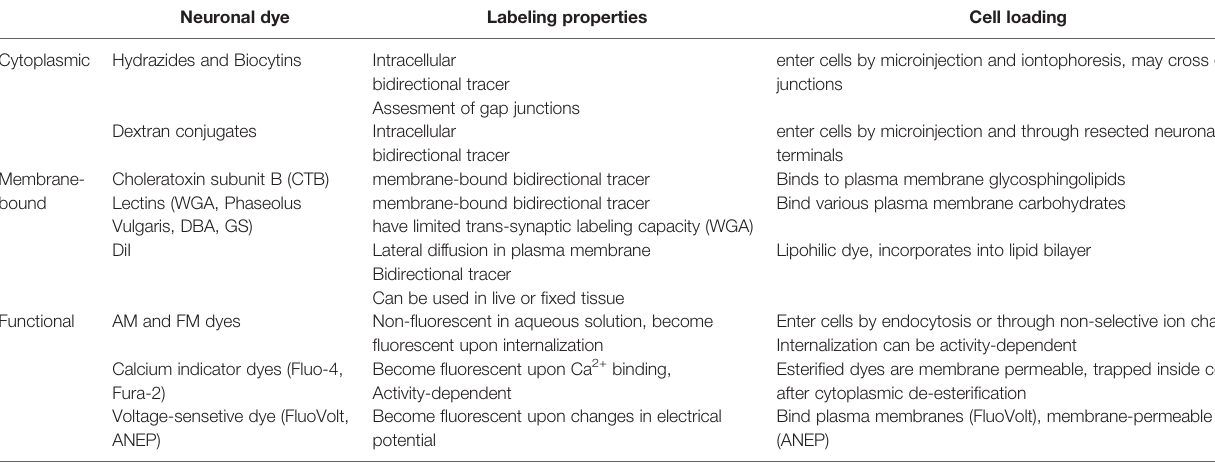
TABLE 4 | Conventional dyes for neuronal